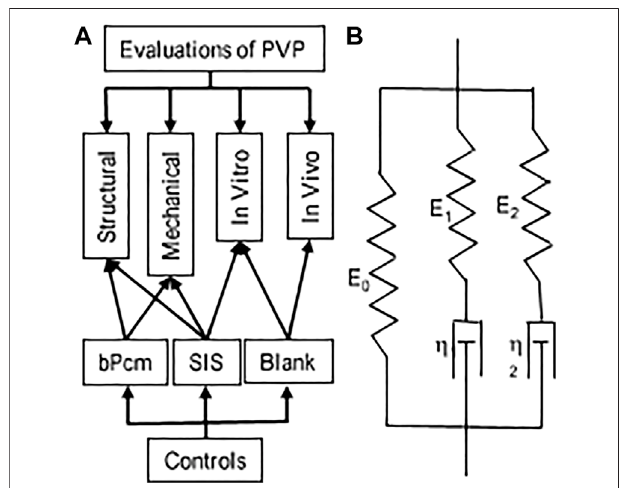
FIGURE 1 | Schematic representations of the evaluation and Maxwell – Wiechert model. (A) An overall picture of the evaluations. (B) Two Maxwell elements with moduli E 1 and E 2 and viscosities η 1 and η 2 provide a model with two relaxation times τ 1 and τ 2 , respectively, that is, a fast- response element ( E 1 and τ 1 ) and a slow-response element ( E 2 and τ 2